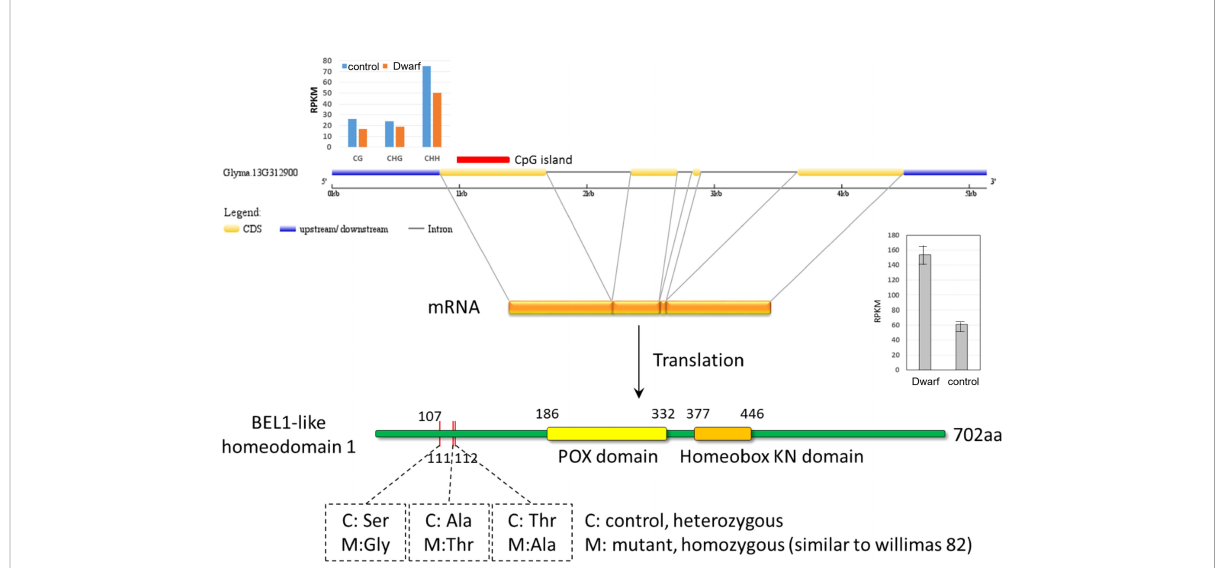
FIGURE 8 Differences of Glyma.13G312990 between dwarf mutant and control at methylation, transcriptional and genomic level. M for the dm mutant, and c for the control cultivar